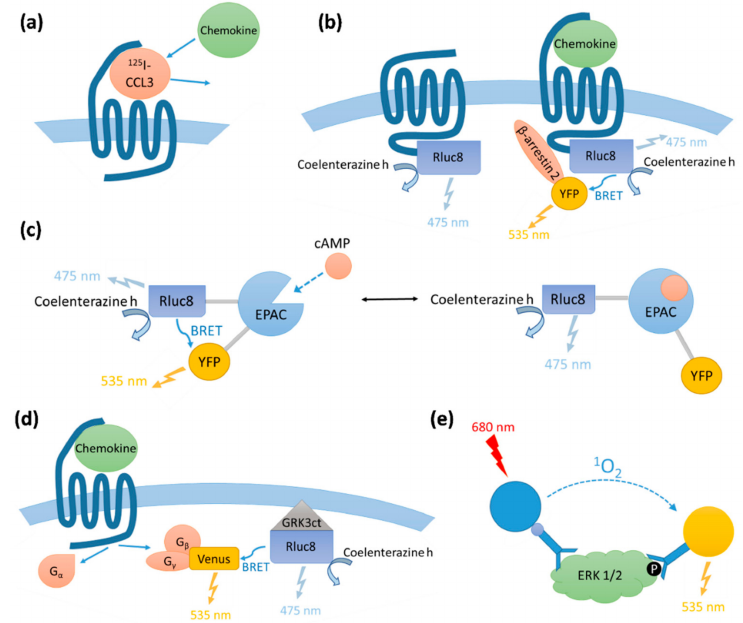
Figure A2. Experimental design for binding and signaling assays. Each panel shows a schematic representation of the assays described in the Materials and Methods: ( a ) competitive radioligand binding measurement using 125 I-CCL3 as a probe, ( b ) β -Arrestin2-YFP recruitment to CCR1-Rluc8, ( c ) inhibition of forskolin-induced cAMP production, with cAMP monitored using the guanine nucleotide exchange protein activated by cAMP (EPAC) linked to a BRET donor and acceptor, ( d ) G protein activation via dissociation of the βγ -Venus subunit, and ( e ) AlphaScreen-based ERK phosphorylation